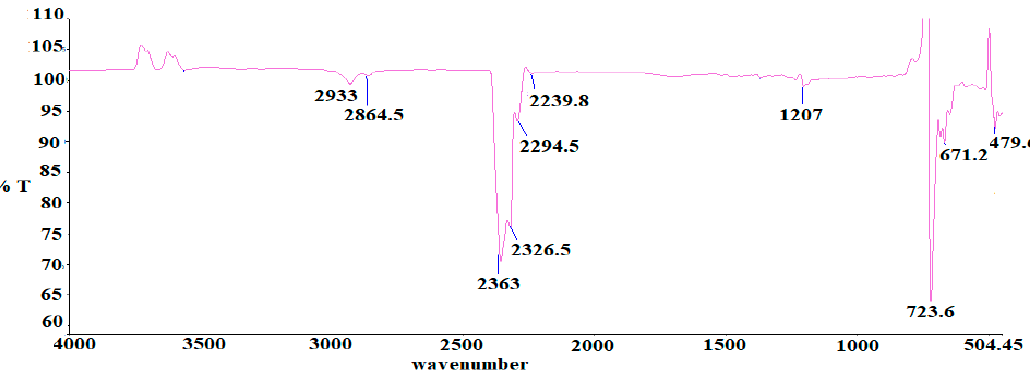
Figure 7. IR spectrum of as ‐ synthesized surfactant in hyphenated TG ‐ IR (curve 3).